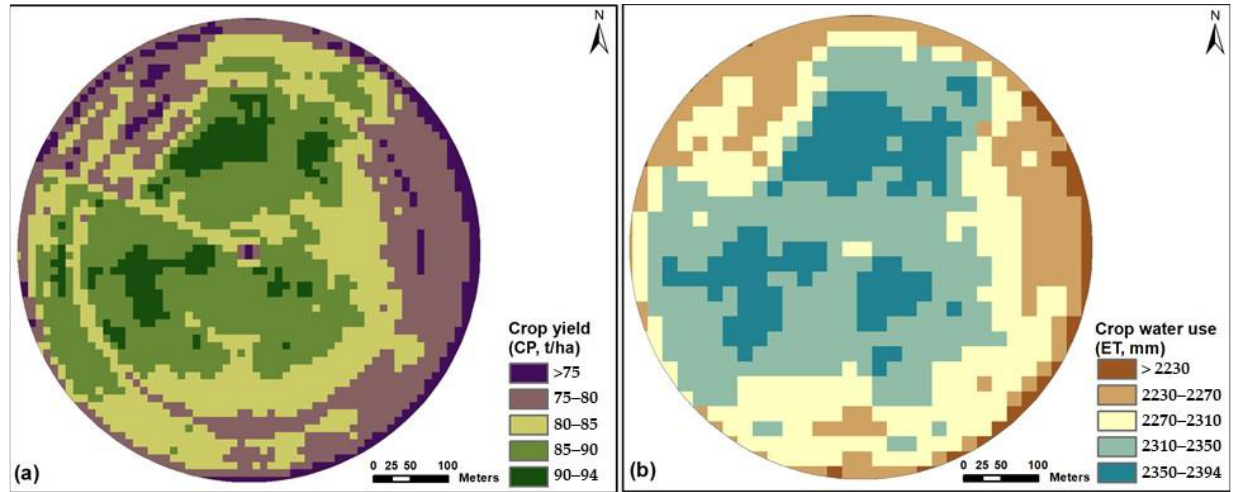
Figure 8. ( a ) Crop yield and ( b ) seasonal crop water use maps of carrot crop.